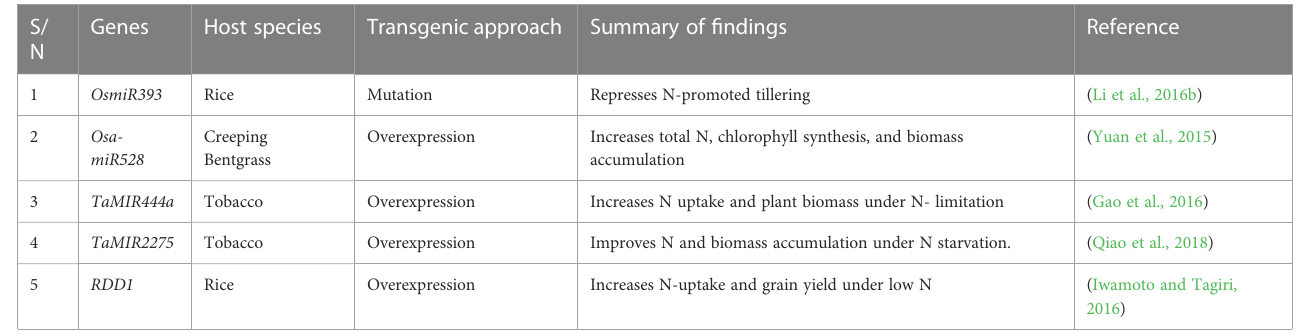
TABLE 3 MicroRNAs involved in nitrogen use ef fi